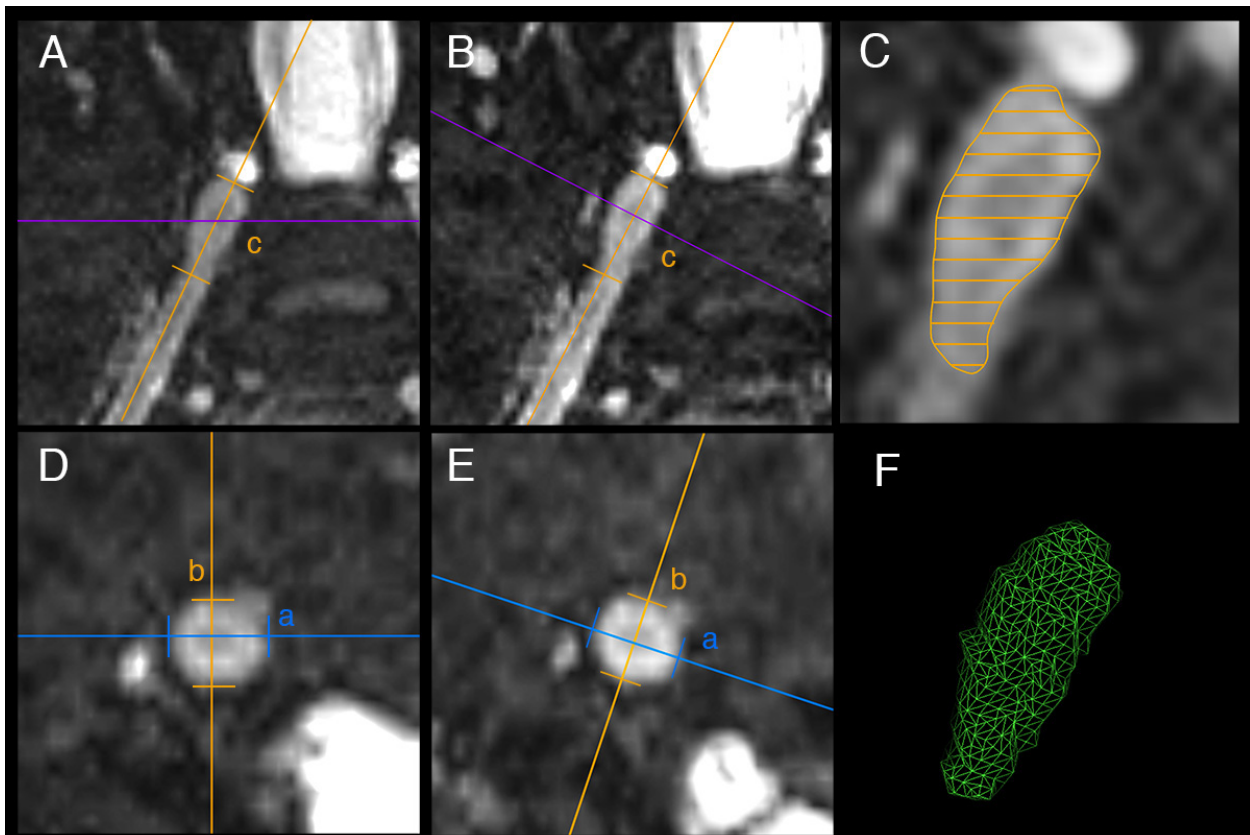
Figure 2. Exemplary images of dorsal root ganglion (DRG) volumetry. For non-axis corrected volume estimation the DRG main axes a, b, and c were measured in standard anatomical reformations (( A ): coronal, ( D ): axial). For axis-corrected volume estimation, main axes were measured in coronal ( B ) and axial ( E ) reformations, that were aligned with the orientation of the individual DRG. Both methods of volume estimation rely on the same formula of an ellipsoid V = π /6 × a × b × c. For exact volumetry, the volume of the DRG was segmented in multiple axial planes (( C ) showing coronal view with axial planes symbolized as parallel lines). Subsequently, a 3D model was created ( F ) and volume was calculated.